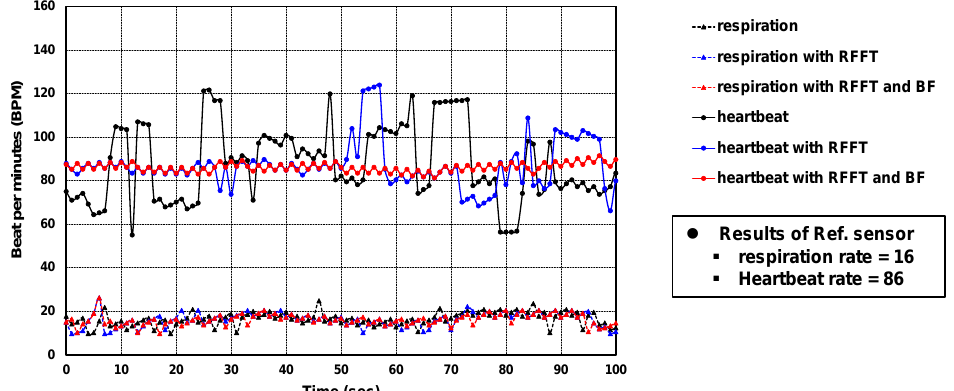
Figure 12. Comparison of algorithm performance without interferer.